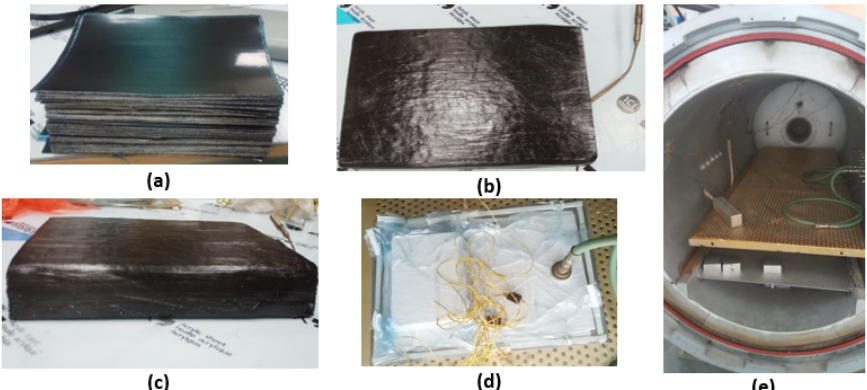
Figure 3. Defining of autoclave curing process for thick laminate: ( a ) Cutting of the pre-preg sheets on Zund cutter plotter. ( b ) Installation of the thermocouple at the mid-plane. ( c ) Final ply layup